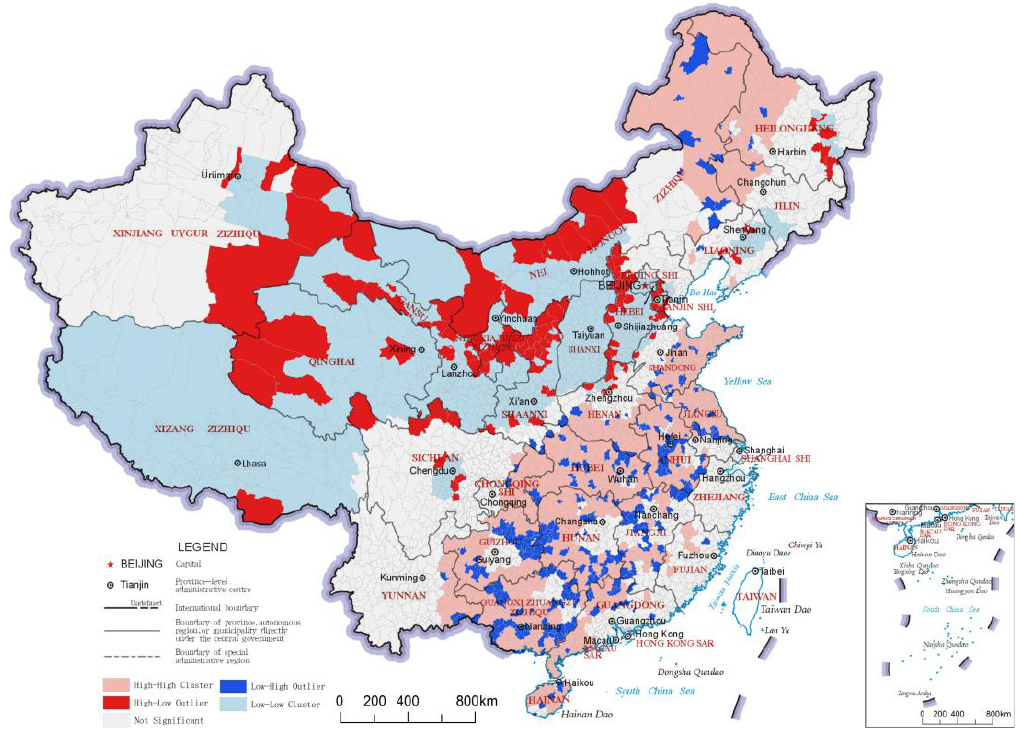
Figure 4. LISA cluster map of provisioning service indices of the county-level regions in China.